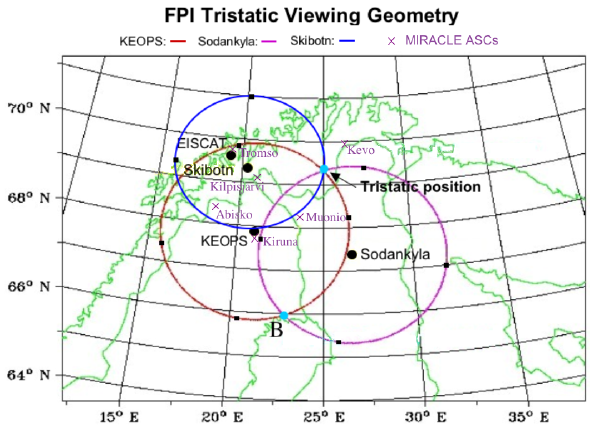
Fig. 1. Fields of view of the three FPIs at Skibotn, KEOPS and Sodankyl¨a and the EISCAT radar at Tromsø, for elevation angles of 45 ◦ for KEOPS and Sodankyl ¨ a and 51.5 ◦ for Skibotn. The dots in- dicate the positions of the volumes viewed by each FPI. Positions A and B are the tristatic and bistatic volumes, respectively, and there is a near tristatic position vertically above KEOPS. Locations of some of the IMAGE magnetometers are also